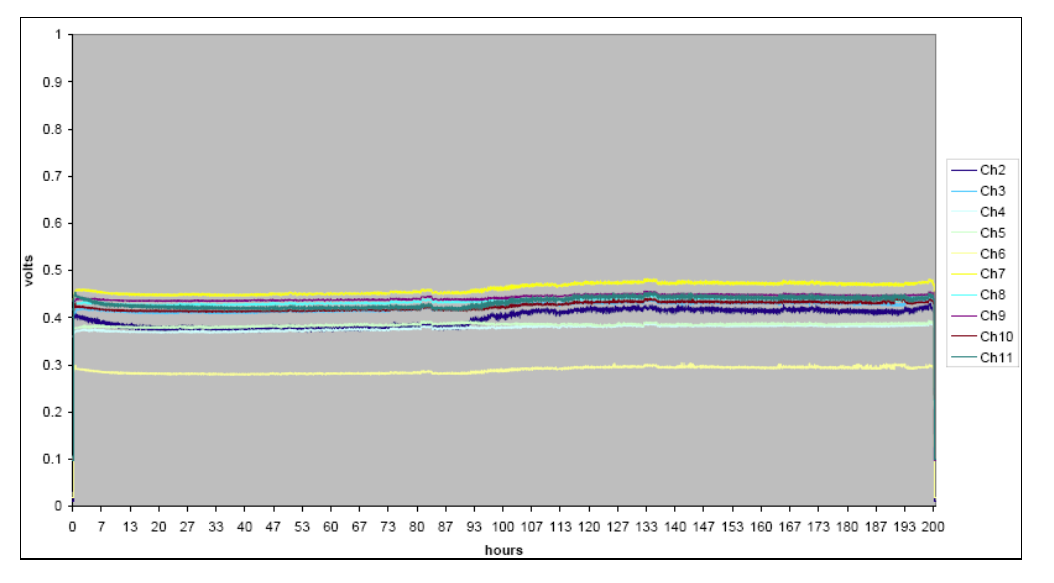
Figure 4. Time behaviour of the accelerometers tested at vibration and 145 o